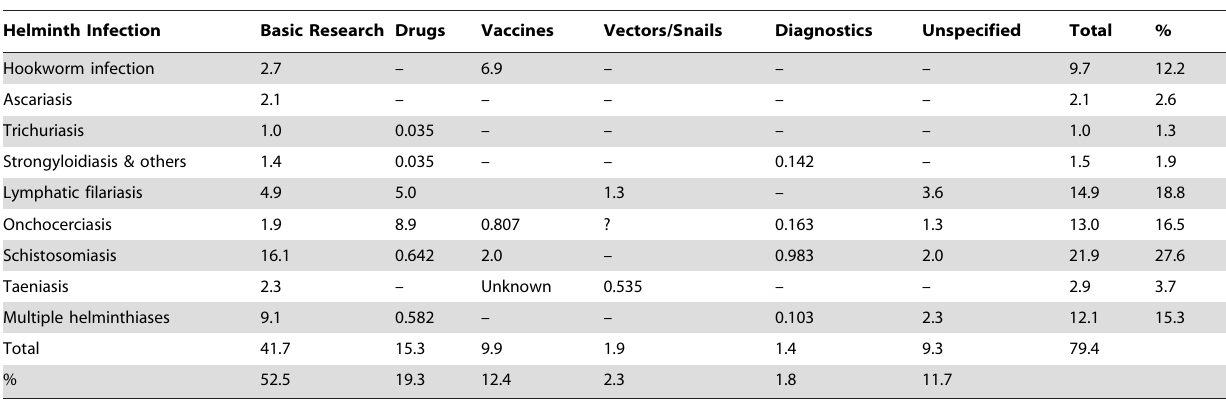
Table 6. Funding of R&D Products for Helminthiases in 2009 (in US$